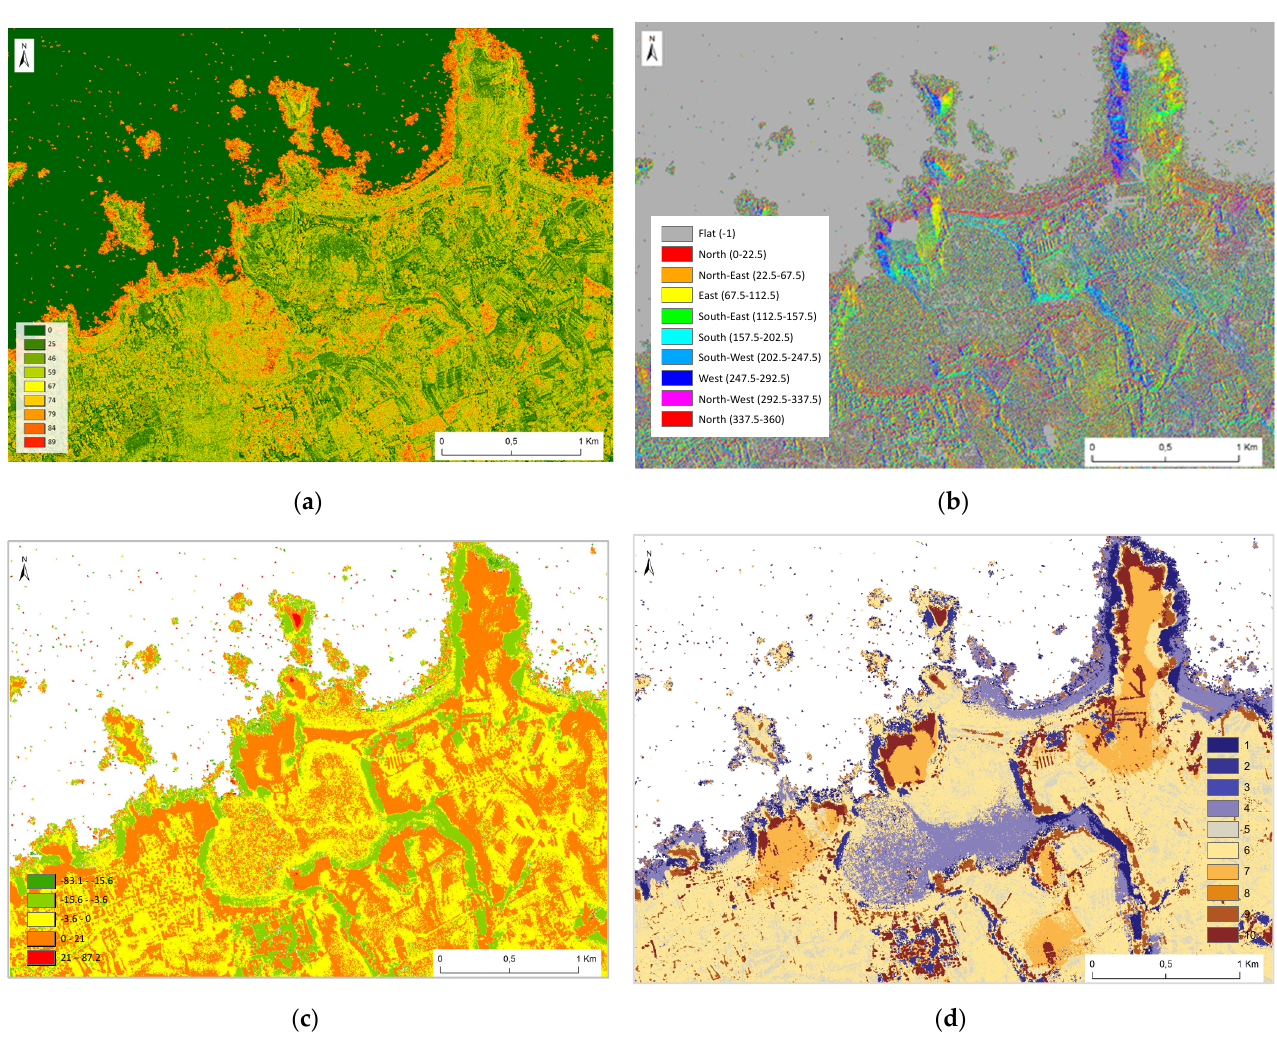
Figure 9. Morphometric variables derived form the best Pleiades–1 DSM#2–3_1: slope in degrees ( a ); aspect ( b ); topographic position index, (TPI) ( c ); TPI–based landform classification ( d ).